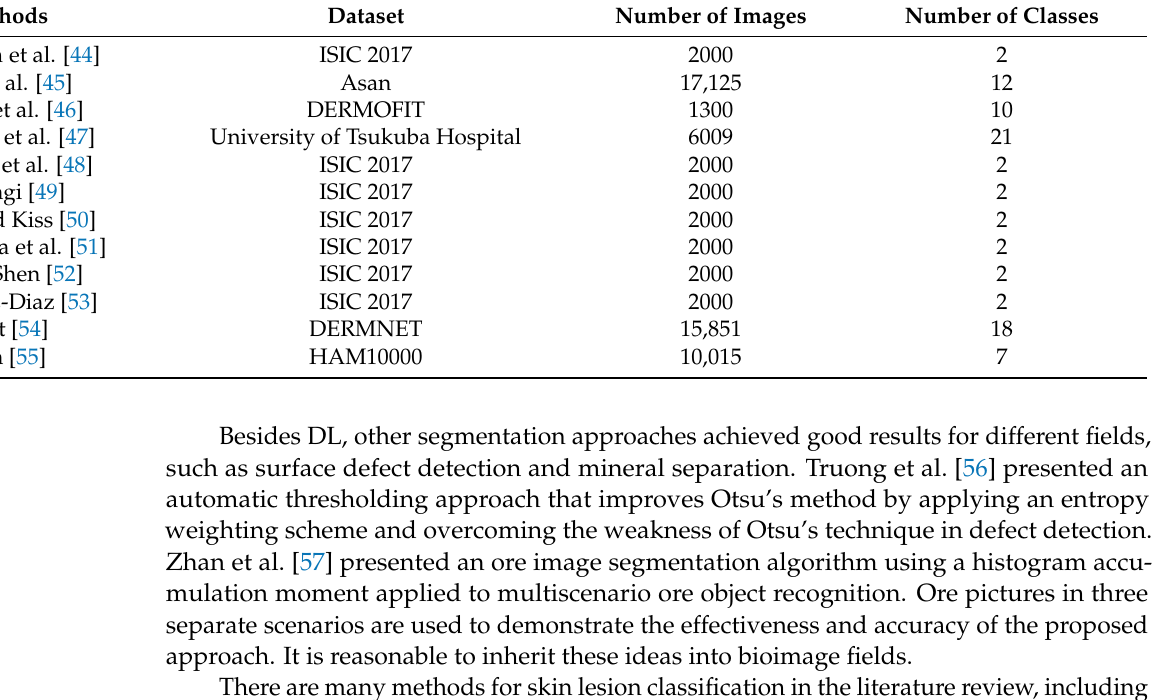
Table 1. Datasets of all DL methods.